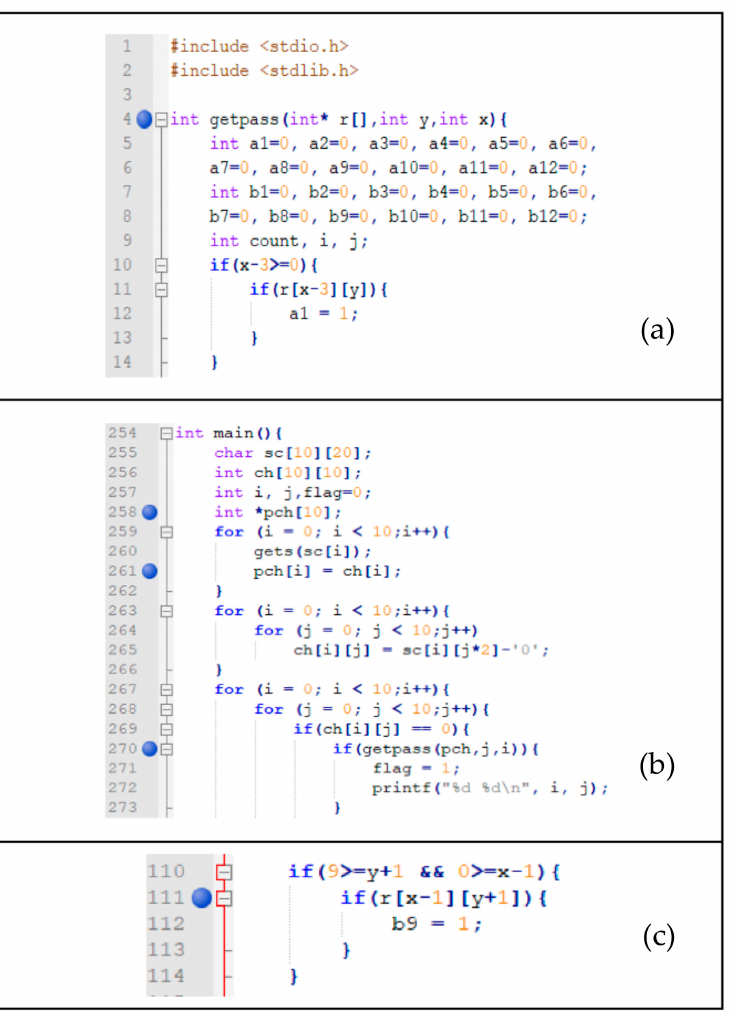
Figure 26. Example program (5), ( a ) define a 10*10 Gobang disk, ( b ) Describe the pch pointer array points to the ch two-dimensional array, the getpass function is called with pch as the parameter, ( c ) describe ‘Segmentation Fault’ indicates that the line points to an unconfigured space.